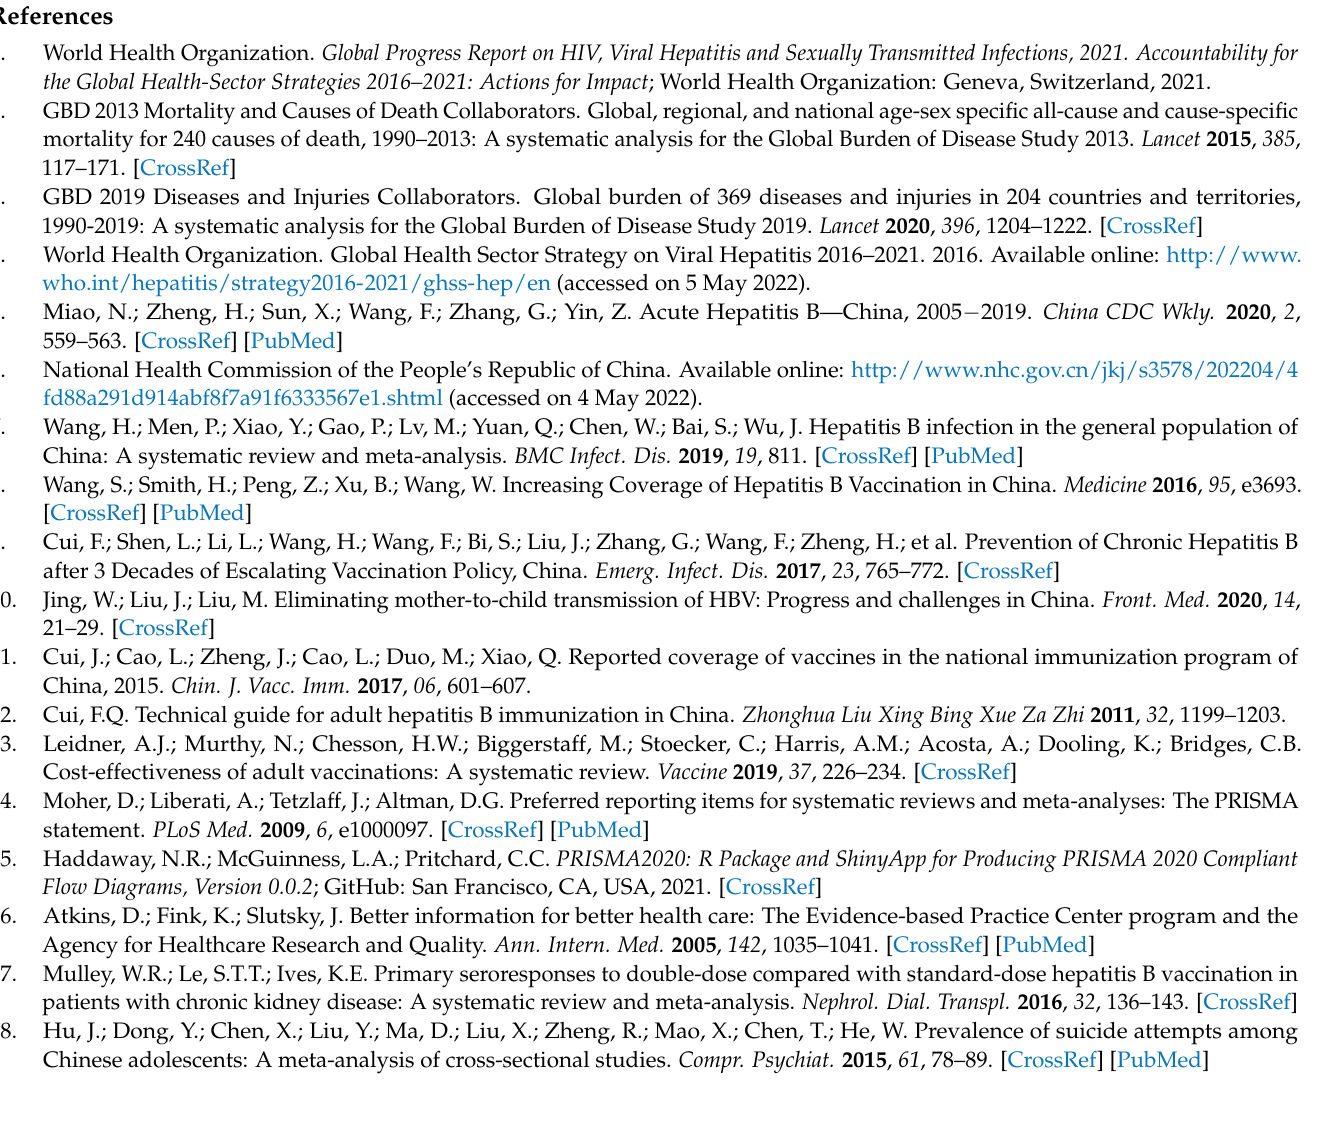
Table S2: AHRQ forms and modified versions; Table S3: Quality assessment of eligible